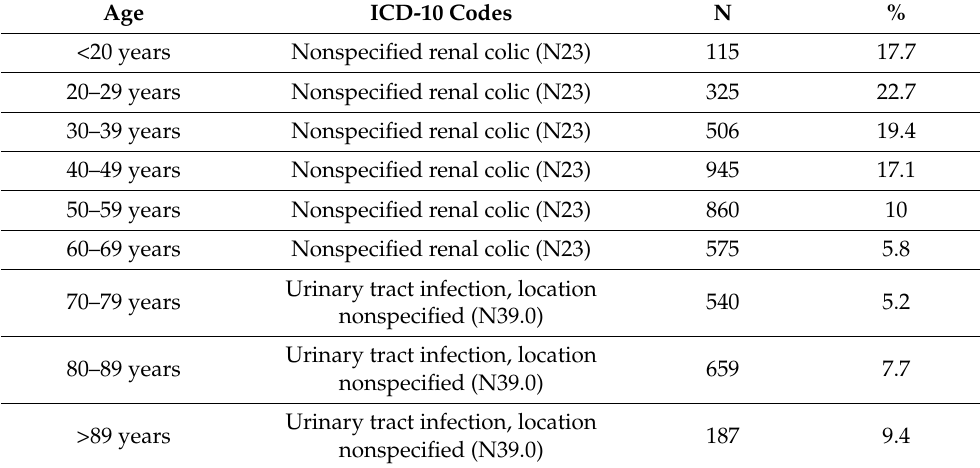
Table 5. Main cause of hospitalization when urolithiasis was not coded as the main diagnosis by age.